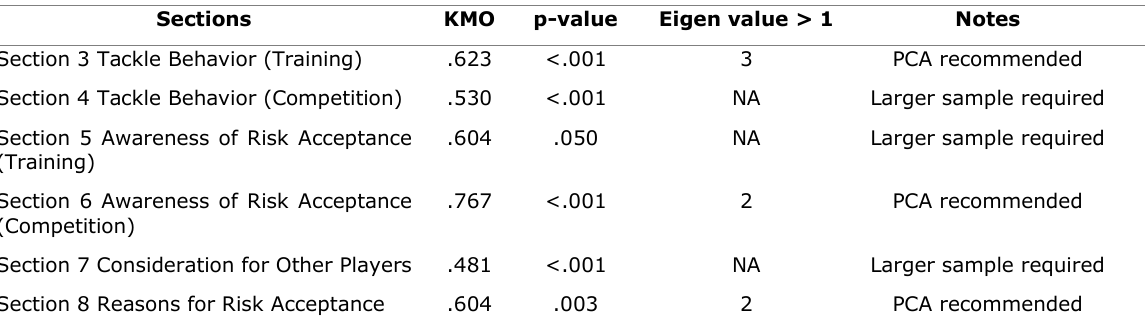
Table 6. Overall PCA results